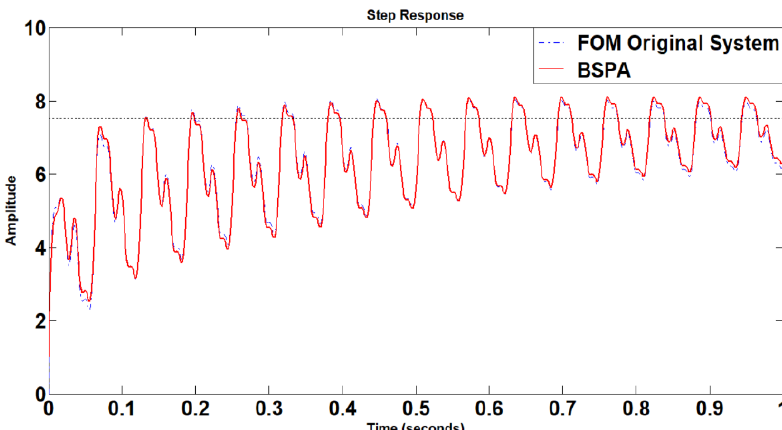
Figure 5. Time response of ROM with OS for one second